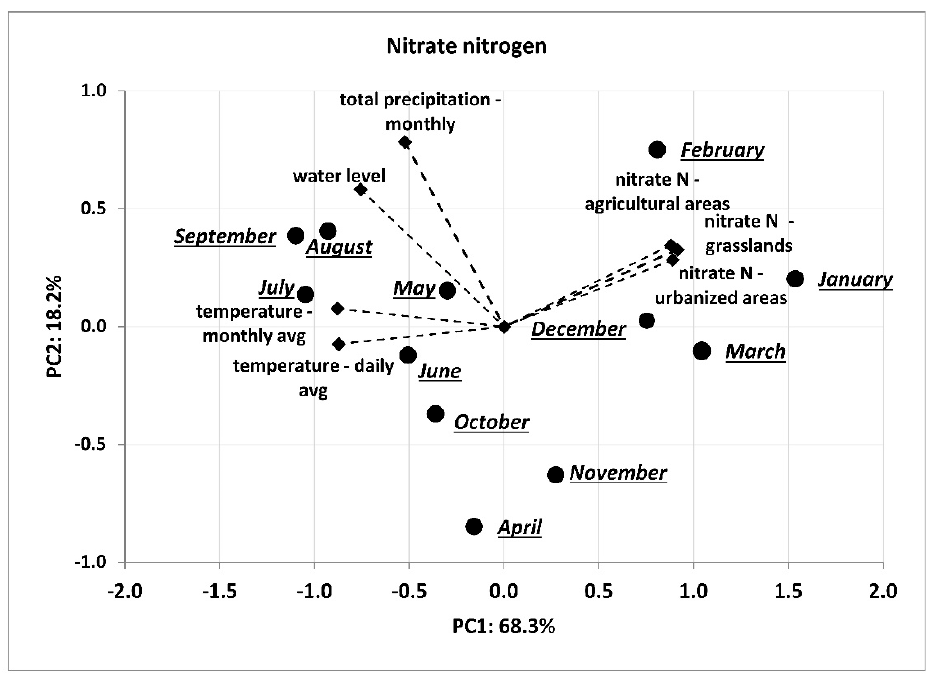
Figure 9. PCA analysis for the relationships between: catchment area land use, weather conditions and nitrate nitrogen concentration in the Utrata River. Ammonia nitrogen concentration in the Utrata River in agricultural areas was strongly positively correlated with total precipitation and water level. In the other types of areas (grasslands and urban areas), this correlation was also positive, but weaker. The concentra- tion of this form of nitrogen in water varies—to some extent—due to changes in water and air temperature (Figure